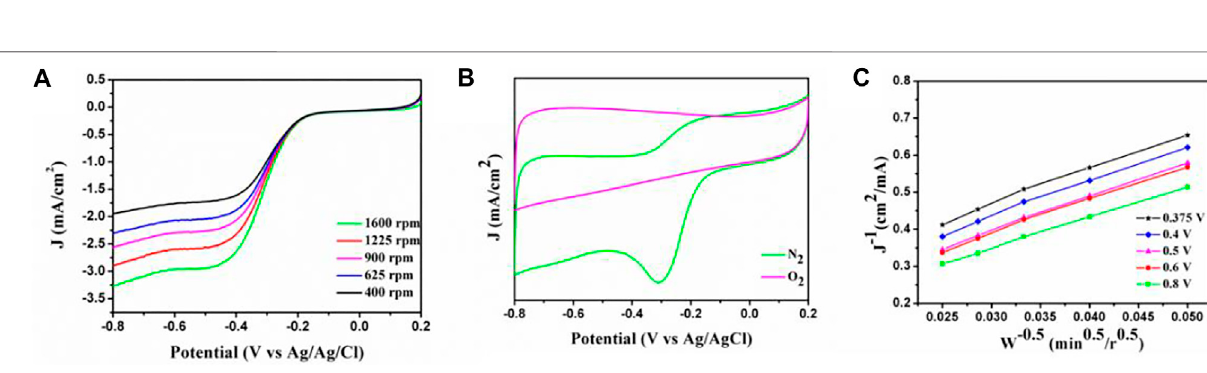
Frontiers in Chemistry |